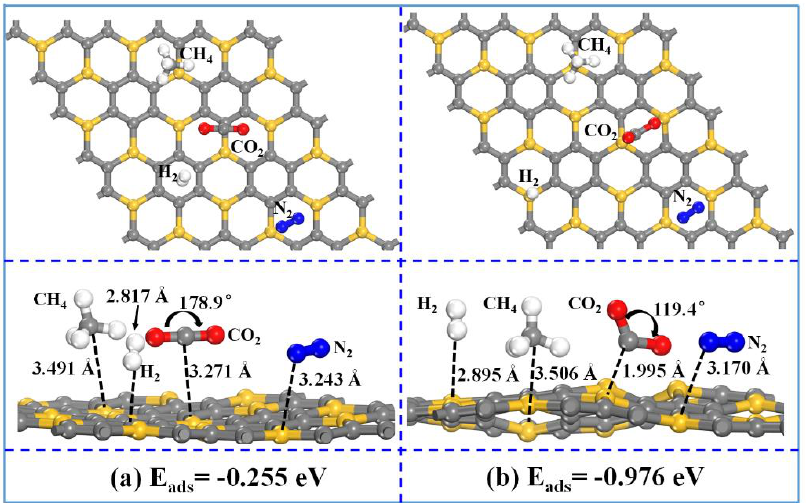
Figure 7. Top and side views of the optimized configurations of the SiC 3 nanosheet with gases molecules (i.e., CO 2 , H 2 , N 2 and CH 4 ) co-adsorption ( a ) without the injection of negative charges, and ( b ) with the injection of negative charges (1.23 × 10 14 e − /cm 2 ). Switching on the injection of negative charges, the modules of H 2 , N 2 and CH 4 move away from the SiC 3 nanosheet. The distance between the molecule and the SiC 3 nanosheet increases from 2.817 to 3.506 Å for H 2 –SiC 3 , from 3.243 to 3.170 Å for N 2 –SiC 3 , and from 3.491 to 3.506 Å for CH 4 –SiC 3 . No obvious electron density distribution overlaps are ob-